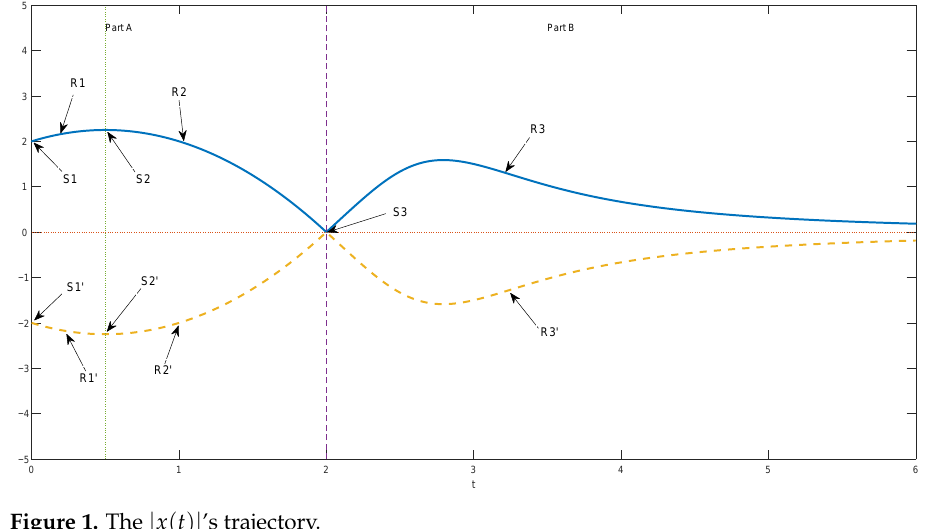
Figure 1. The | x ( t ) | ’s